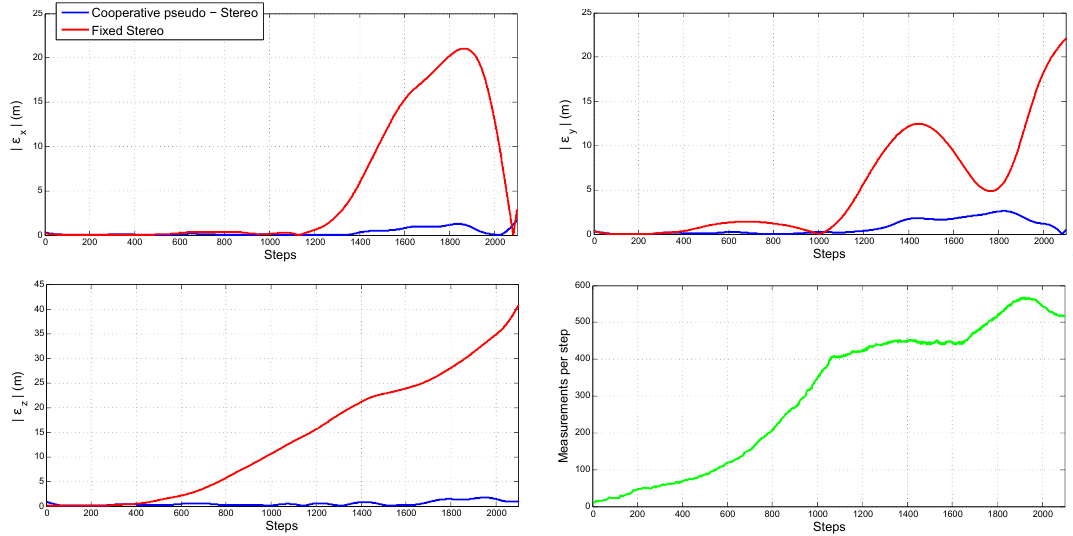
Figure 11. Comparison of the quality of the measurements obtained from a fixed stereo system and those obtained with the cooperative pseudo-stereo